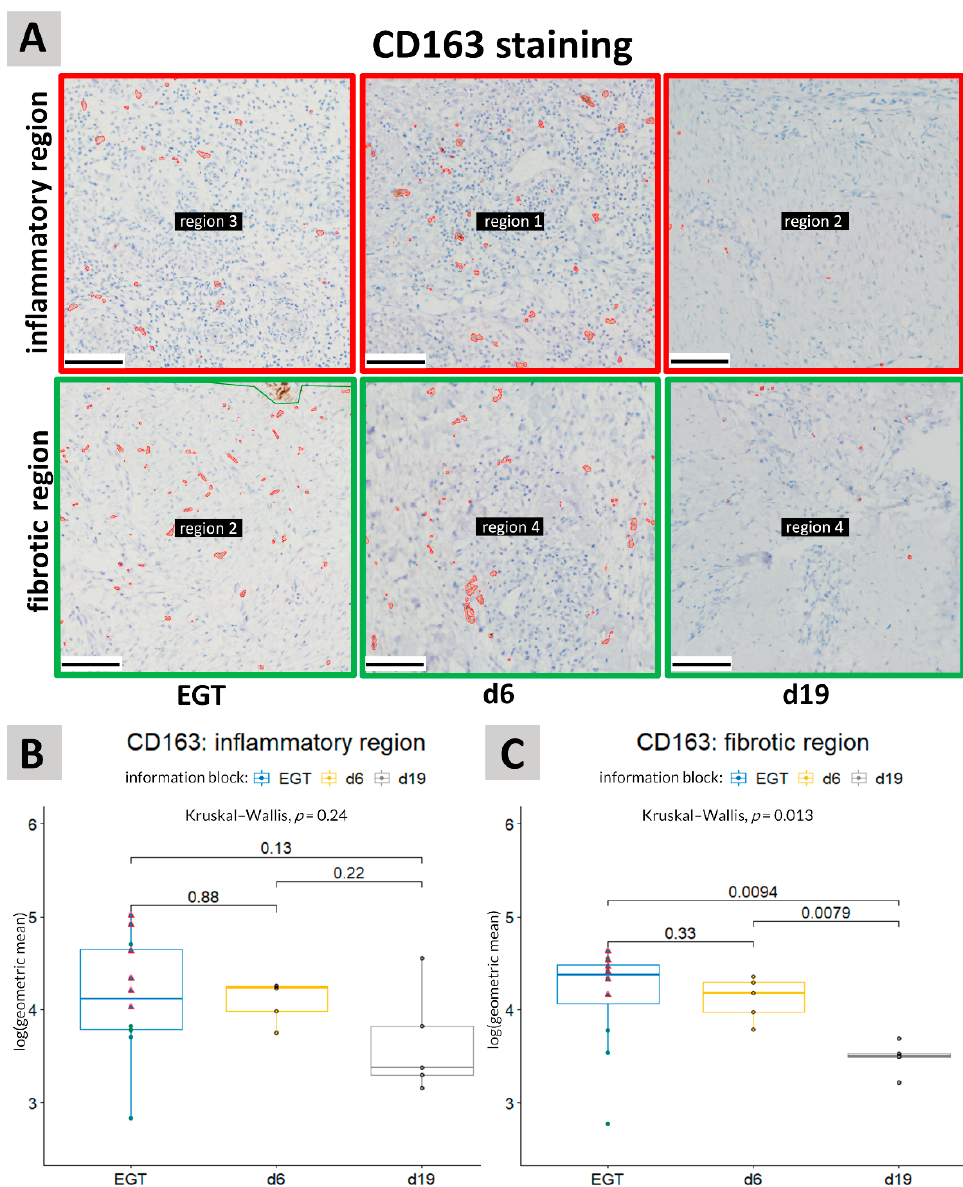
Figure 5. CD163 staining. ( A ): Representative pictures of immunohistochemical stainings to show the differences in CD163 immunolabeling between the inflammatory and fibrotic regions in EGT and physiological healing in experimental wounds at 6 days (d6) or 19 days (d19) post-injury. Scale bar = 100 µ m. ( B , C ): CD163 staining was quantified in sections of horse wound tissue in the inflammatory regions ( B ) and in the fibrotic regions ( C ). An unpaired Kruskal–Wallis was performed to detect the differences between the different groups, i.e., EGT wounds, d6 and d19. A pairwise comparison was then made between the different groups with the aid of an unpaired Wilcoxon test. No significant differences were detected between the groups in the inflammatory regions. In the fibrotic regions, a significant difference was observed between wounds 19 days post-injury and both EGT and wounds 6 days post-injury. A p -value of <0.05 was considered significant. Green circles represent horses with an age between 7 and 15 years (age range of the experimental horses) and the red triangles represent younger horses. See also Figure S4 for the unprocessed